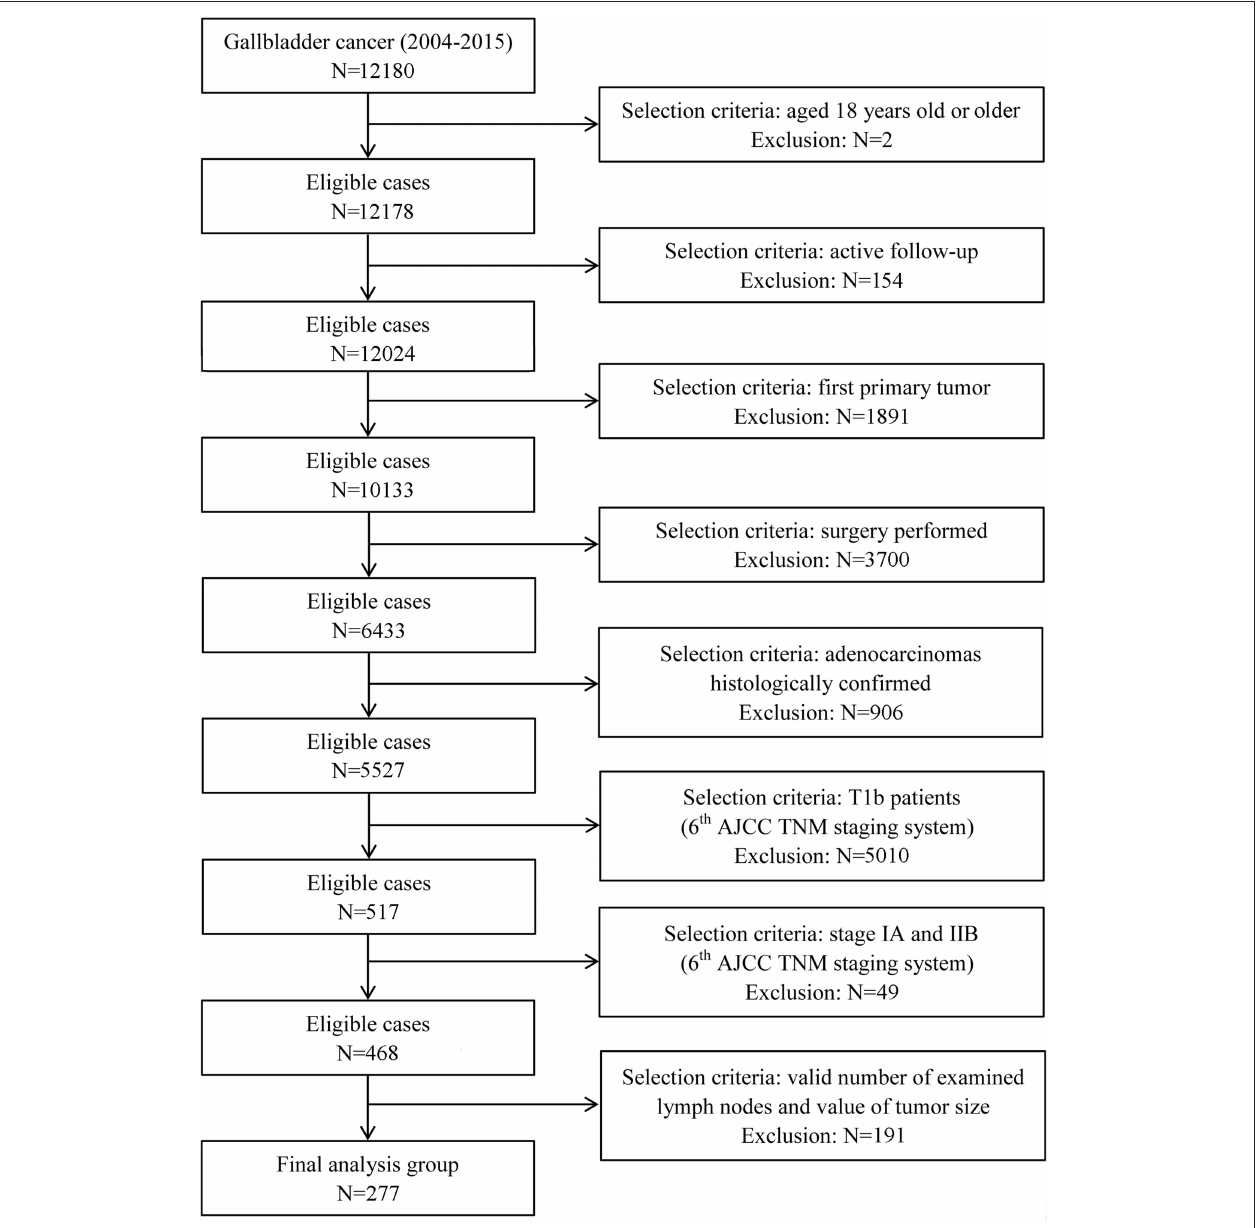
FIGURE 1 | Patient selection